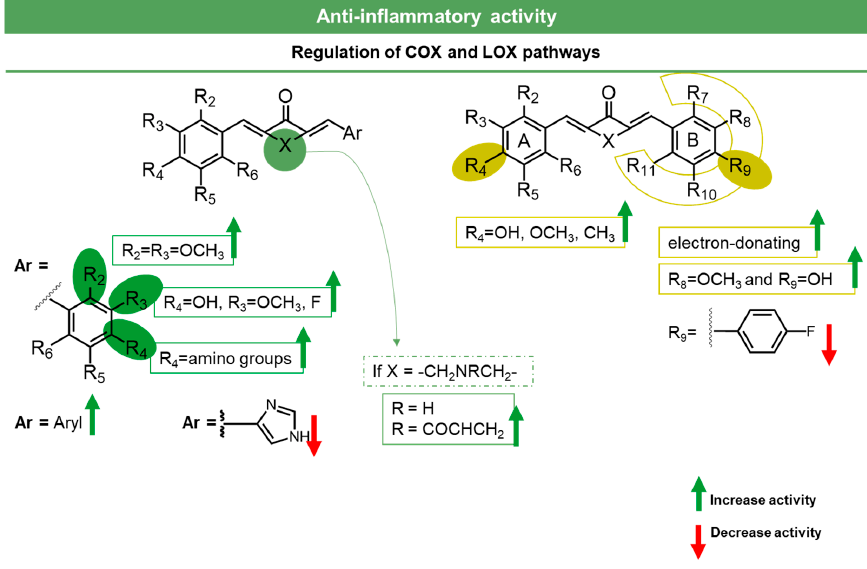
Figure 13. Putative SAR for the effects of diarylpentanoids on the regulation of COX and LOX pathways.